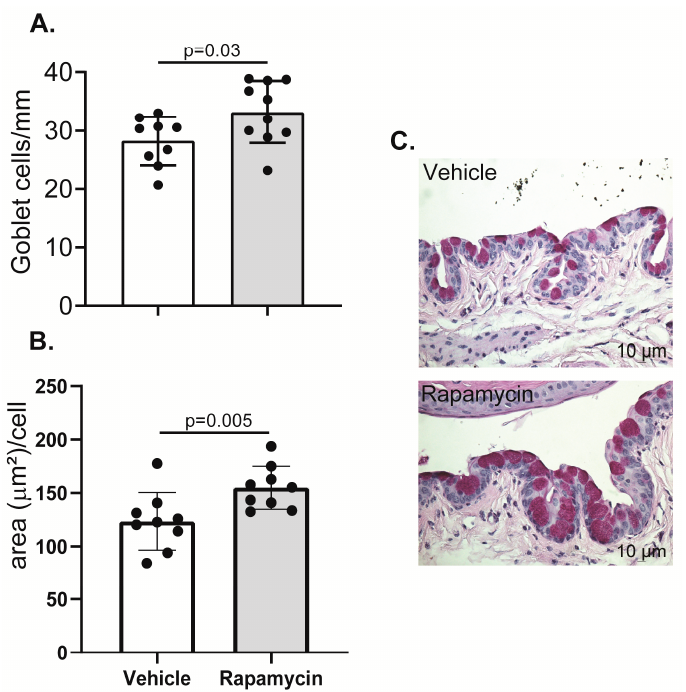
Figure 5. Rapamycin treatment rescues conjunctival goblet cells in aged mice. Eyes from the aged mice in each group were collected, fixed and embedded in paraffin, for histological processing and Periodic acid-Schiff staining. Finally, numbers of goblet cells in the palpebral conjunctiva of the whole eye were counted ( A ) and area was quantified ( B ) by light microscopy. ( C ) Representative image of the PAS+ goblet cells (purple) in the conjunctiva of either vehicle or rapamycin-treated mice ( n = 9– 10/group; each dot represents one animal and error bars indicate the standard deviation (SD) of the mean, Mann–Whitney test).